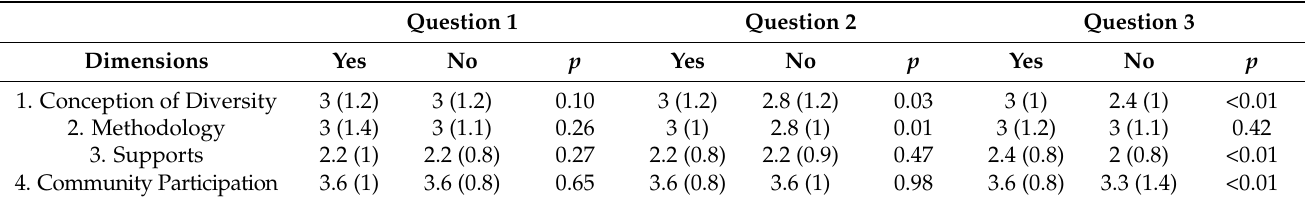
Table 3. Analysis of the CEFI-R questionnaire differences for every dimension according to the answers to the dichotomous questions.